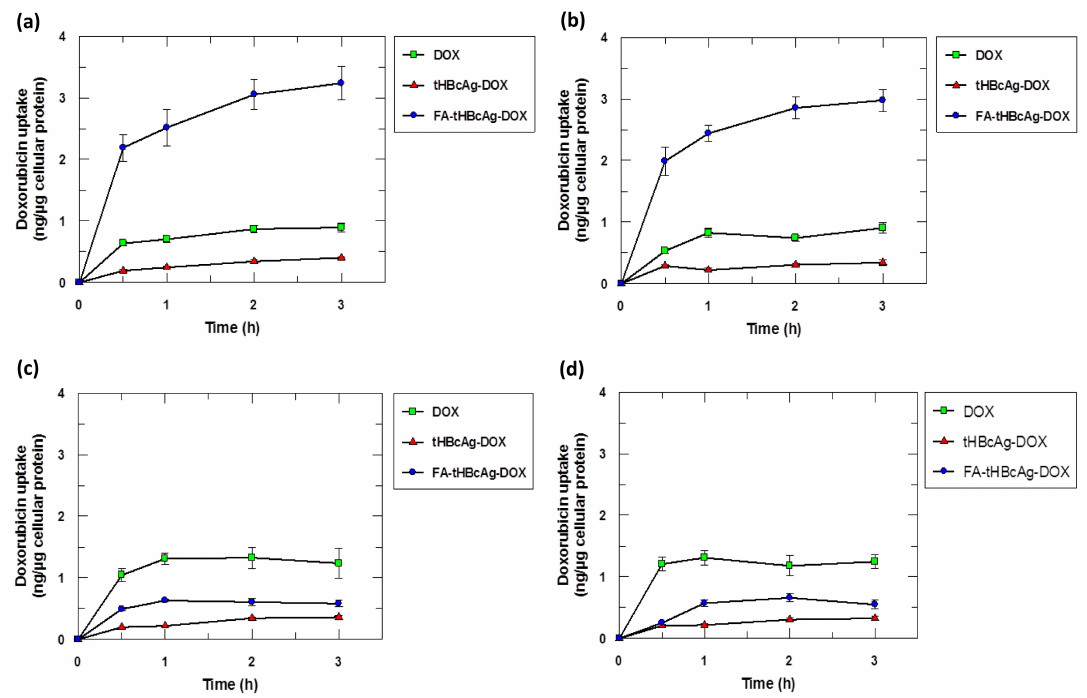
Figure 7. Doxorubicin (DOX) uptake by cancer and normal cells. DOX uptake by cancer ( a ) HeLa and ( b ) HT29 cells, and normal ( c ) 3T3 and ( d ) CCD-112 cells incubated with DOX alone, DOX-conjugated tHBcAg VLNPs (tHBcAg-DOX), dual-conjugated tHBcAg VLNPs with folic acid (FA) and DOX (FA-tHBcAg-DOX). Data represent means ± standard deviations (SD) of triplicate